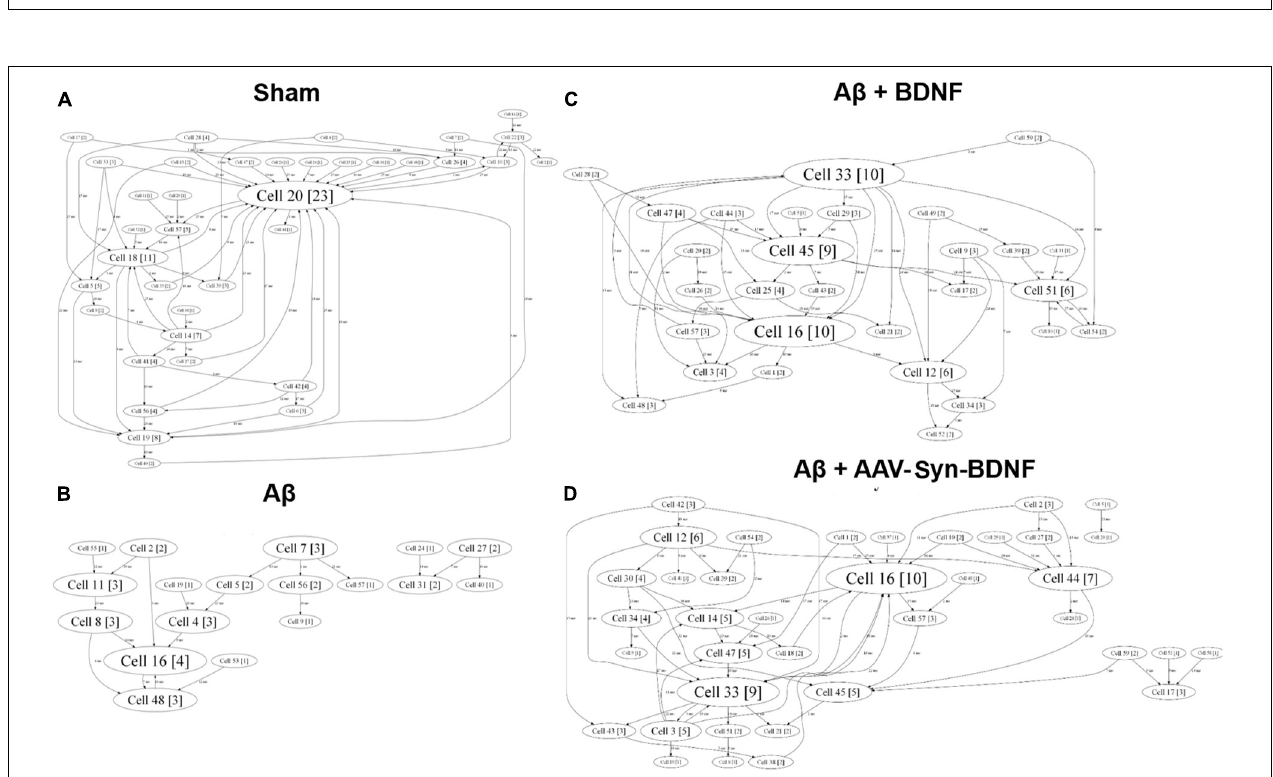
FIGURE 9 | Internal functional structure of neural networks in the primary hippocampal cultures on DIV 21. Graphical representation of the correlated connections among neurons in the network. The electrode number is presented as “Cell X.” The number of connections on the electrode is indicated in square brackets. The vertex size is proportional to the number of significant connections. (A) Sham; (B) A β ; (C) BNDF; (D) A β +AAV-syn-BDNF. A neuronal network in an intact primary hippocampal culture has a complex architecture, which includes several active hubs. Chronic application of synthetic A β simplified the internal neural network structure. BDNF preserved the complexity of neural network architecture and maintained the active centers in the network throughout the entire observation period.